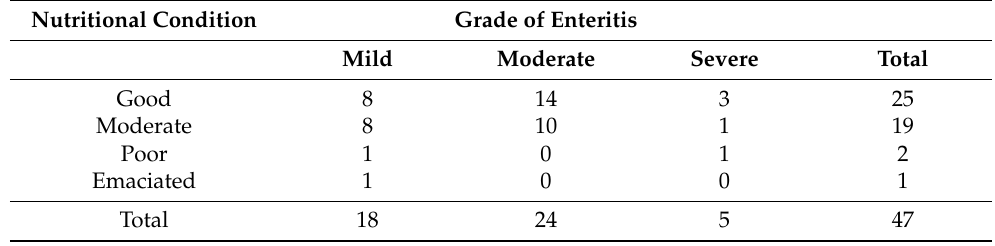
Figure 7. Ulcerative gastritis of the gizzard of a male Common Eider.